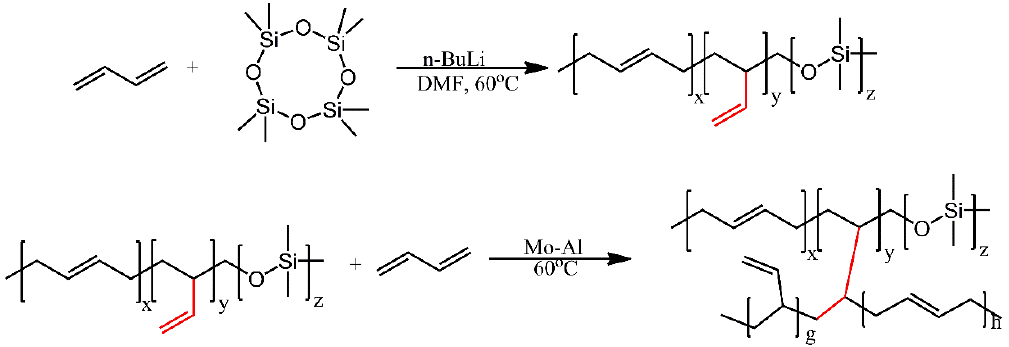
Figure 18. Schematic illustration for the preparation of 1,2-PB-g-Si. The vinyl group is highlighted in red for emphasis on its transformation. Based on Ref.